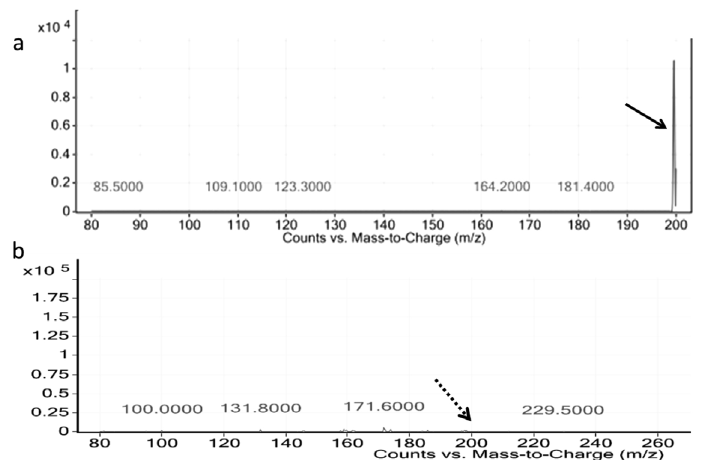
Fig. 2. LC-MS analysis of AHL of Pseudomonas aeruginosa a) Control b) grown with